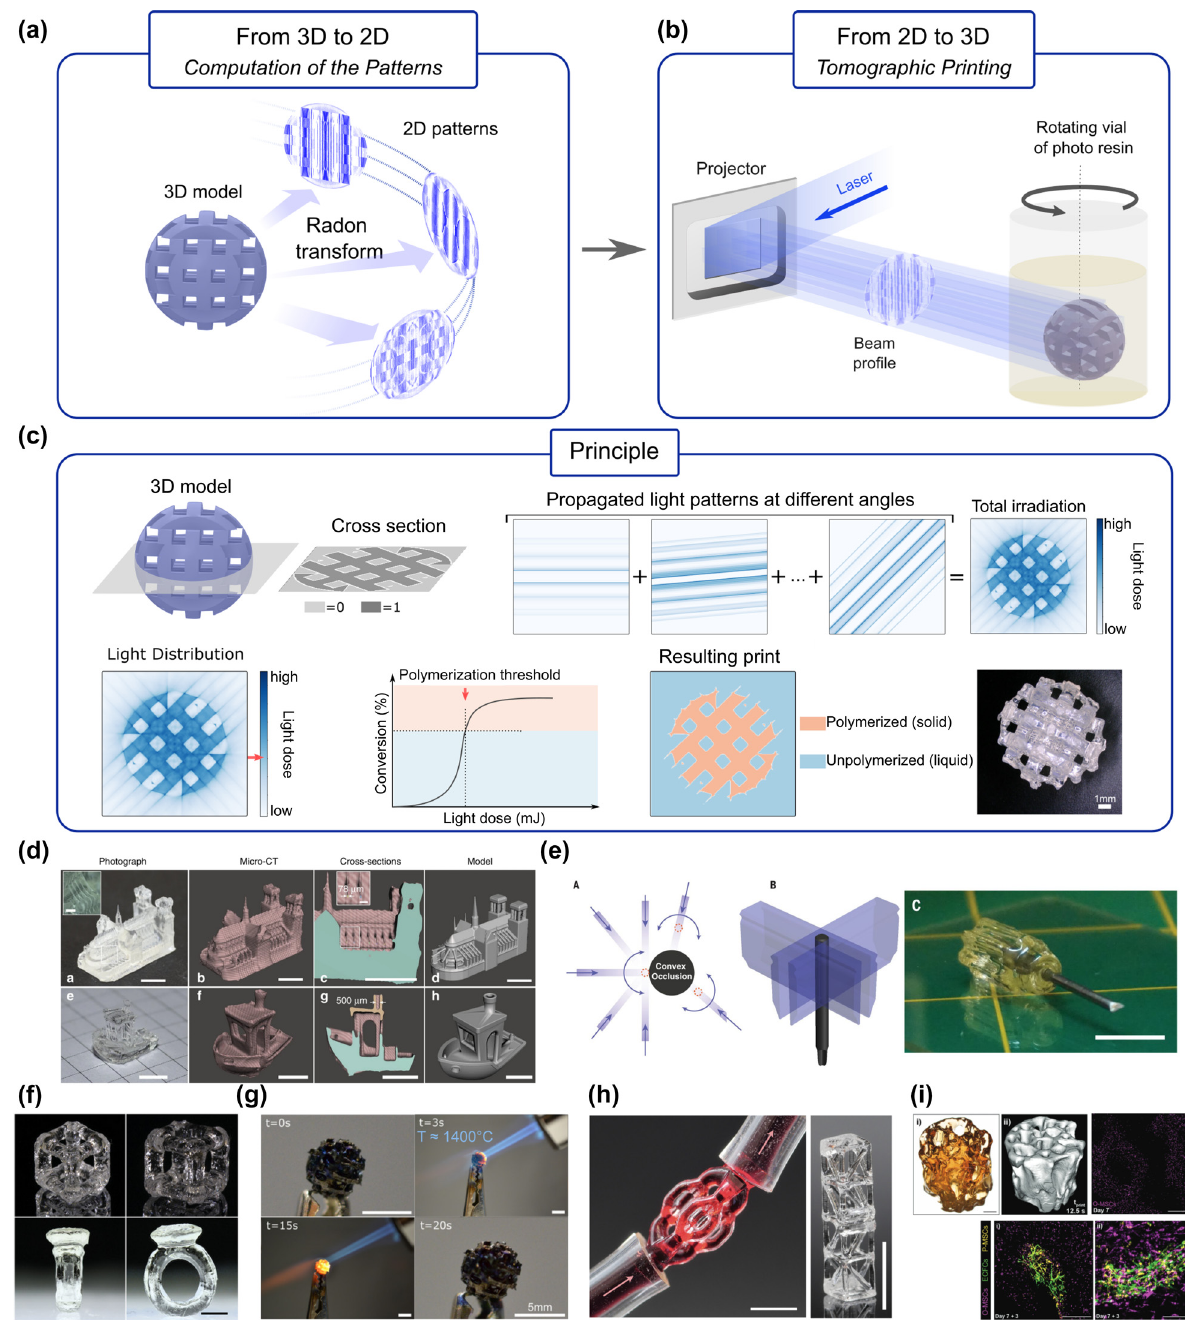
Figure 2: Volumetric additive manufacturing as tomographic back-projection. (a) Radon transform allows calculating the set of 2D tomographic patterns from the 3D model. (b) The back-projection of these patterns into a rotating vial containing a photosensitive resin triggers its solidification. (c) Tomographic VAM exploits the nonlinear thresholded response of corresponding photosensitive materials to light-induced polymerization. This polymerization threshold ensures the fabrication of the target object only, even if the resin outside the object’s target volume inevitably receives some light after having been illuminated from multiple angles. The liquid unpolymerized resin can be washed away after the print. Tomographic VAM has been used to (d) produce high-resolution support-free structures (taken from [36], Copyright Springer-Nature); (e) overprint around pre-existing solid objects (taken from [37], Copyright AAAS); fabricate (f) objects with tunable mechanical properties from thiol-ene resins (taken from [48], Copyright Wiley), (g) heat-resistant polymer-derived silicon oxycarbide ceramics (rearranged from [50], temperature indicated, Copyright Wiley), (h) nanoparticle-based silica glass devices (taken from [51], Copyright AAAS); and (i) bioprint cell-laden hydrogels (taken from [46], Copyright Wiley). Scale bars: (d, f, g) 5 mm, (e) 10 mm, (h) 2 mm, (i) (from top left to bottom right) 2 mm, 1 mm, 500 μ m, 250 μ